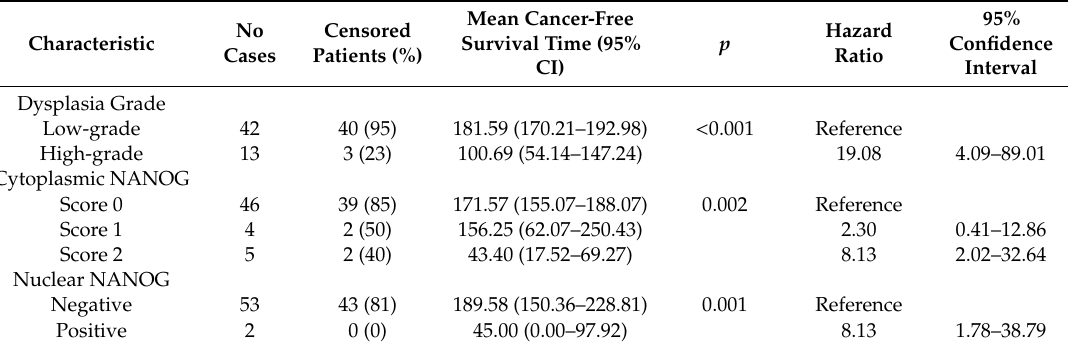
Table 3. Univariate Kaplan–Meier and Cox cancer-free survival analysis in 55 patients with